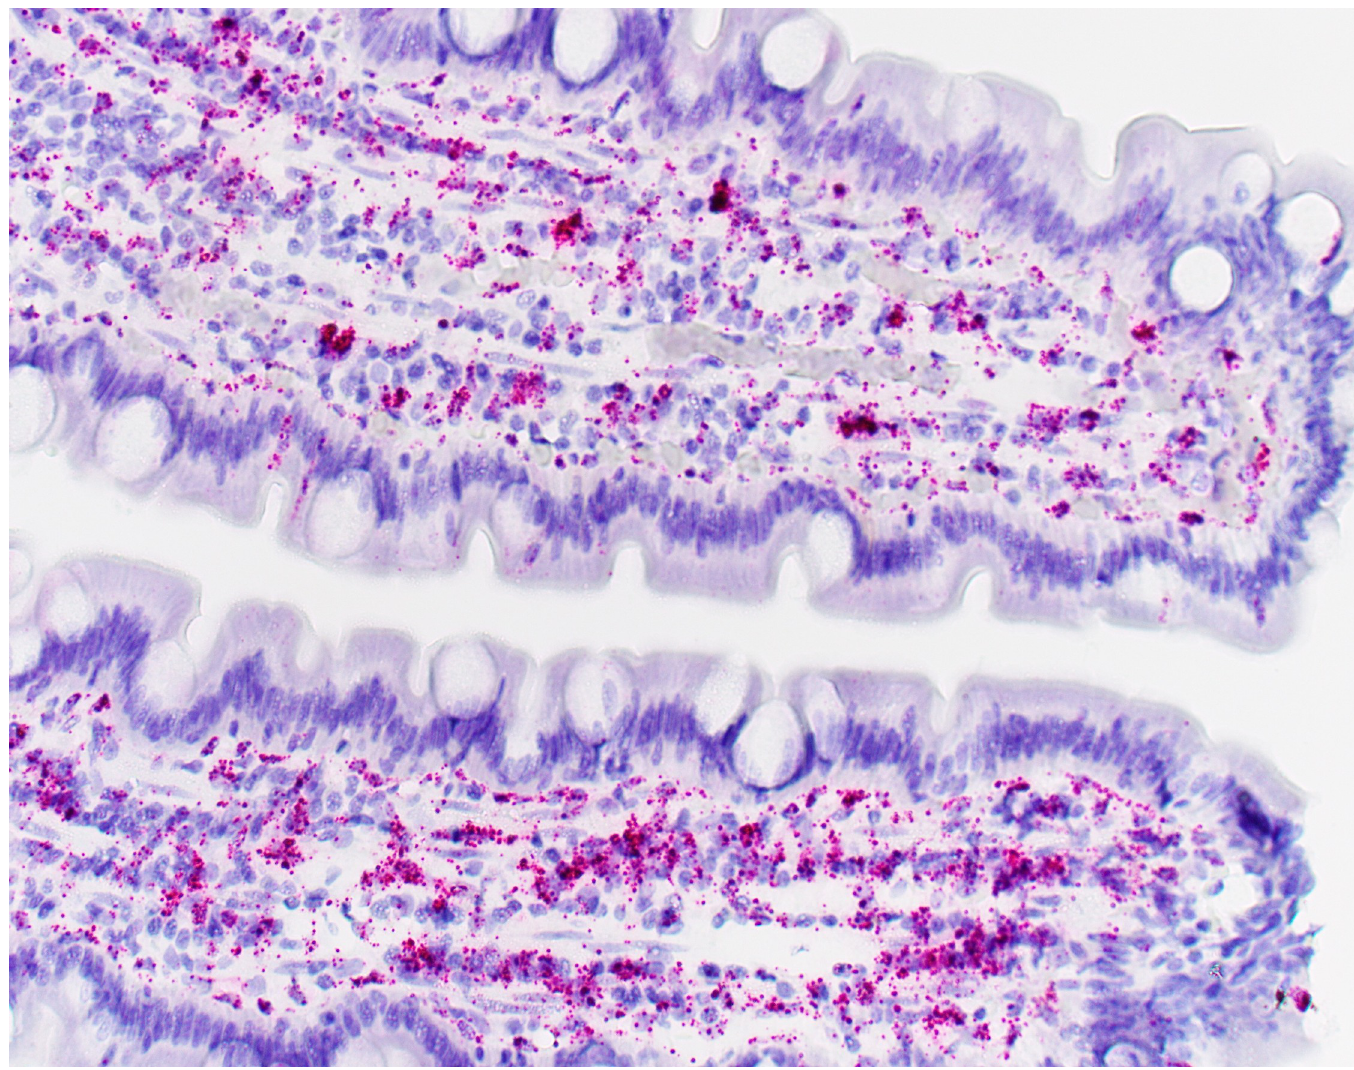
Fig 3. RNA in situ hybridization of IDO-1 mRNA in the duodenal mucosa of a dog with protein-losing enteropathy.